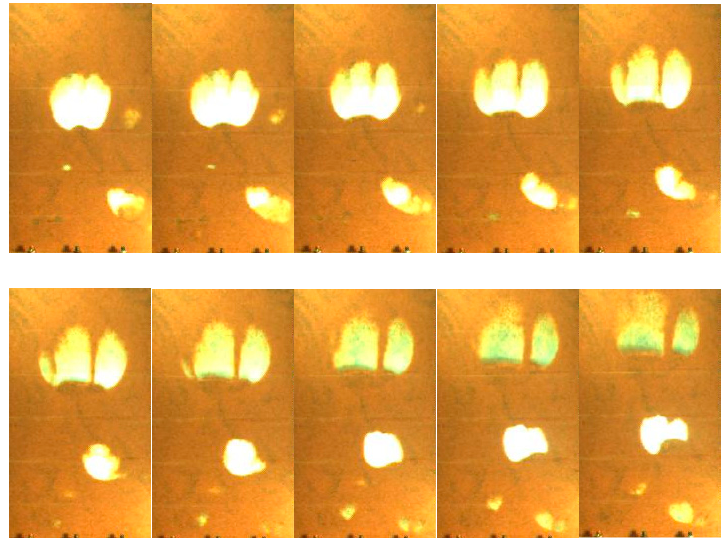
Figure 10. Descending processes of particles penetrated through bubble.